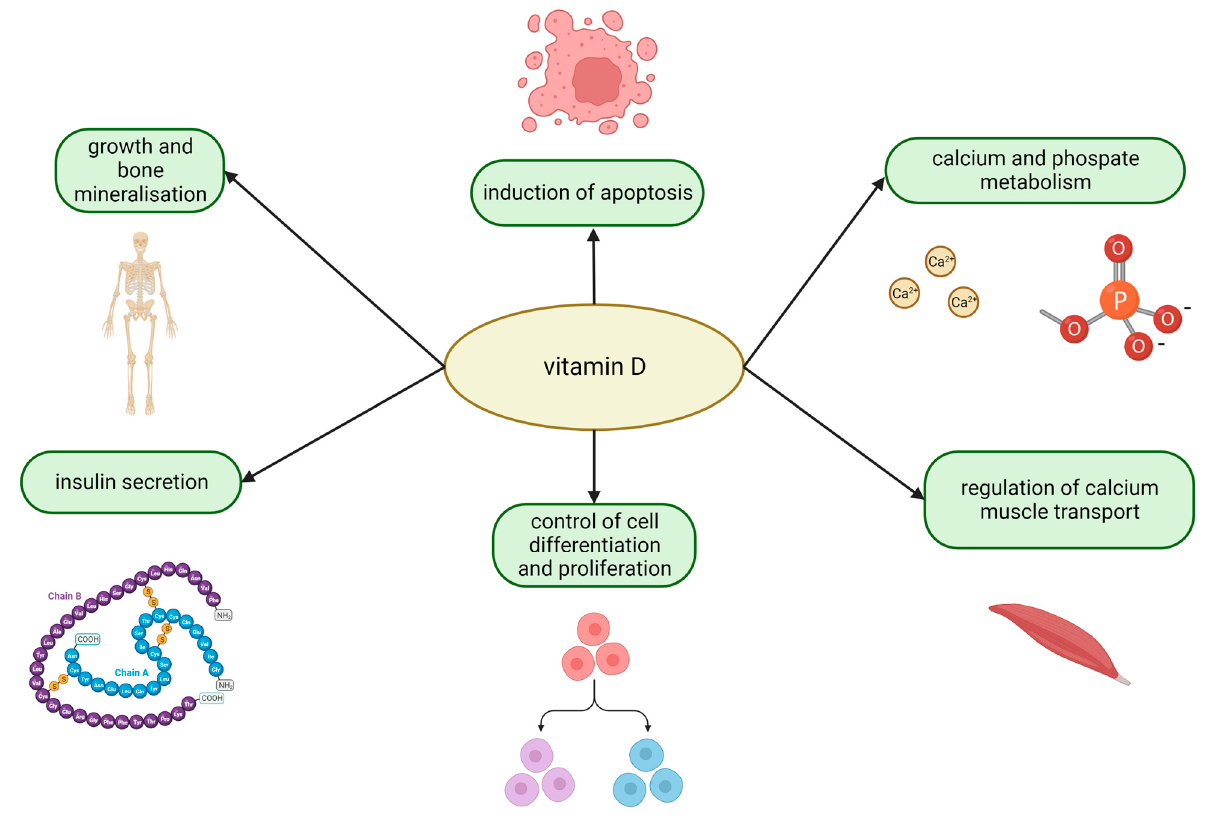
Figure 1. The major biological functions of vitamin D. Vitamin D is a multifunctional protein with antiproliferative and immunomodulating activities. Besides its well-known role in growth and bone mineralization, as well as in calcium an phosphate metabolism, vitamin D regulates apoptosis and controls cell differentiation and proliferation. Vitamin D is a fundamental component that controls the transport of calcium in muscles and is required for healthy insulin secretion.